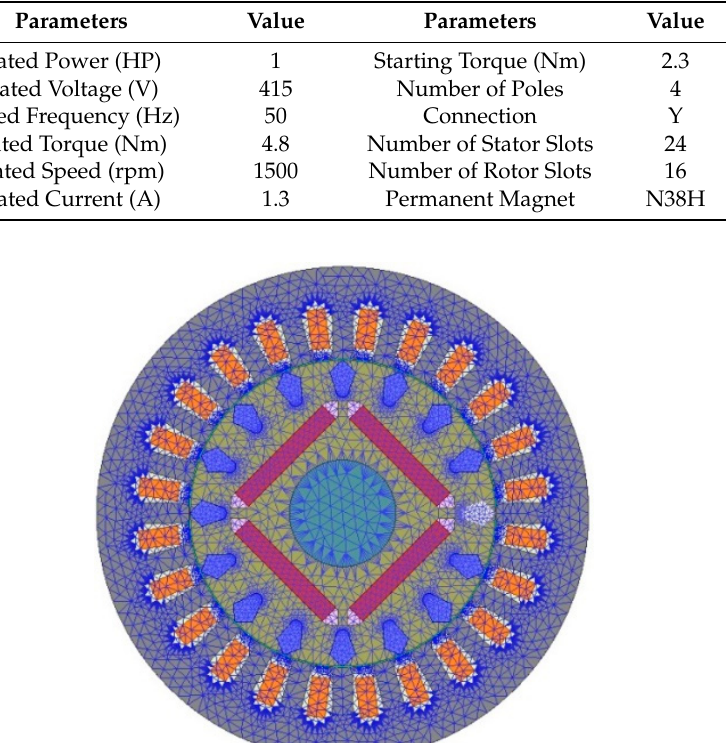
Figure 8. ( a ) The experimental test rig and ( b ) the rotor with one broken rotor bar (BRB).